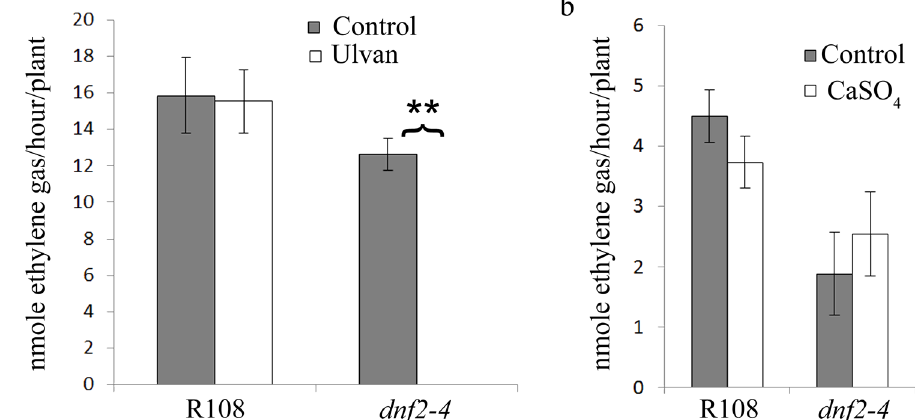
Figure 6. Ulvan abolishes dnf2 nitrogen fixation on permissive condition. M. truncatula WT R108 and dnf2–4 plants were cultivated on agarose BNM supplemented or not with 1% ulvan. Acetylene reduction assays were conducted on plants 27 dpi with S. medicae WSM419 (n=8) (a). M. truncatula WT R108 and dnf2–4 plants were cultivated on Phytagel BNM supplemented or not with 10 mM CaSO 4 . Acetylene reduction assays were conducted on plants 14 dpi with S. medicae WSM419 (n=5) (b). A Mann-Whitney test was performed between WT and dnf2-1 mutant for each condition. Stars indicate significant differences (** p-value , 1e-03) Error bars represent standard errors.